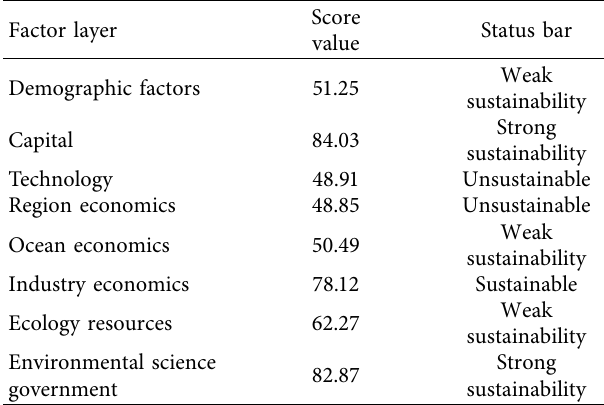
Table 3: Score of the evaluation factor layer. Table 4: Evaluation score of marine biological industry sustainable